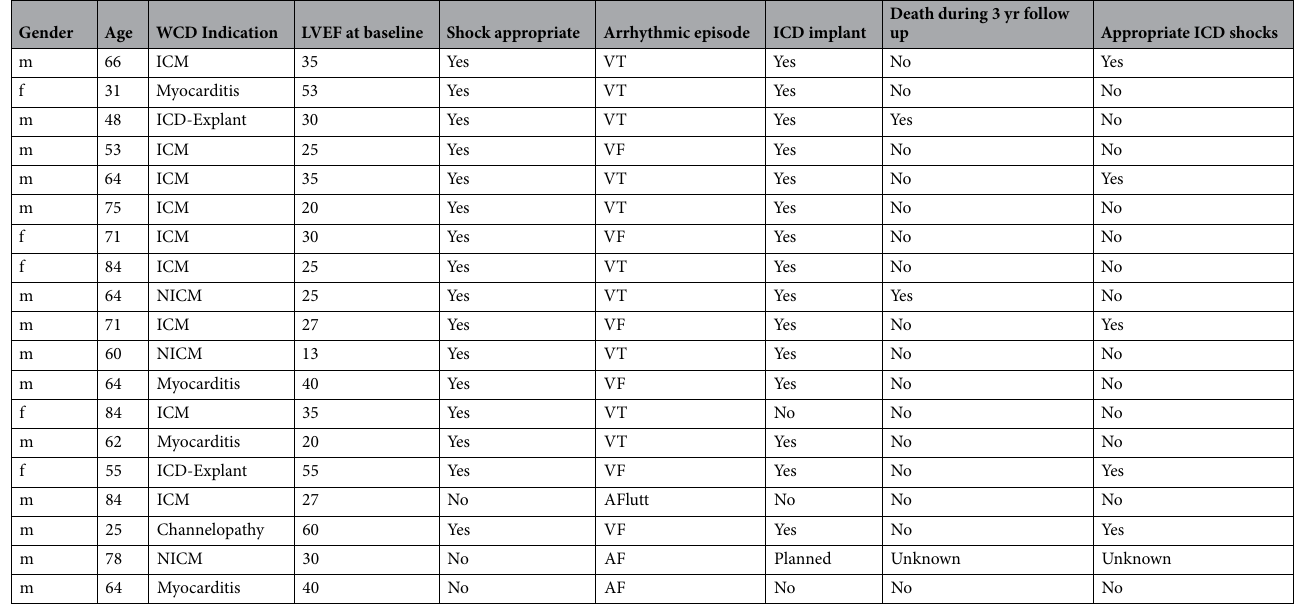
Table 4. WCD Shock Characteristics according to appropriate and inappropriate manner, n = 19. A.Flutt atrial flutter, AF atrial fibrillation, VT ventricular